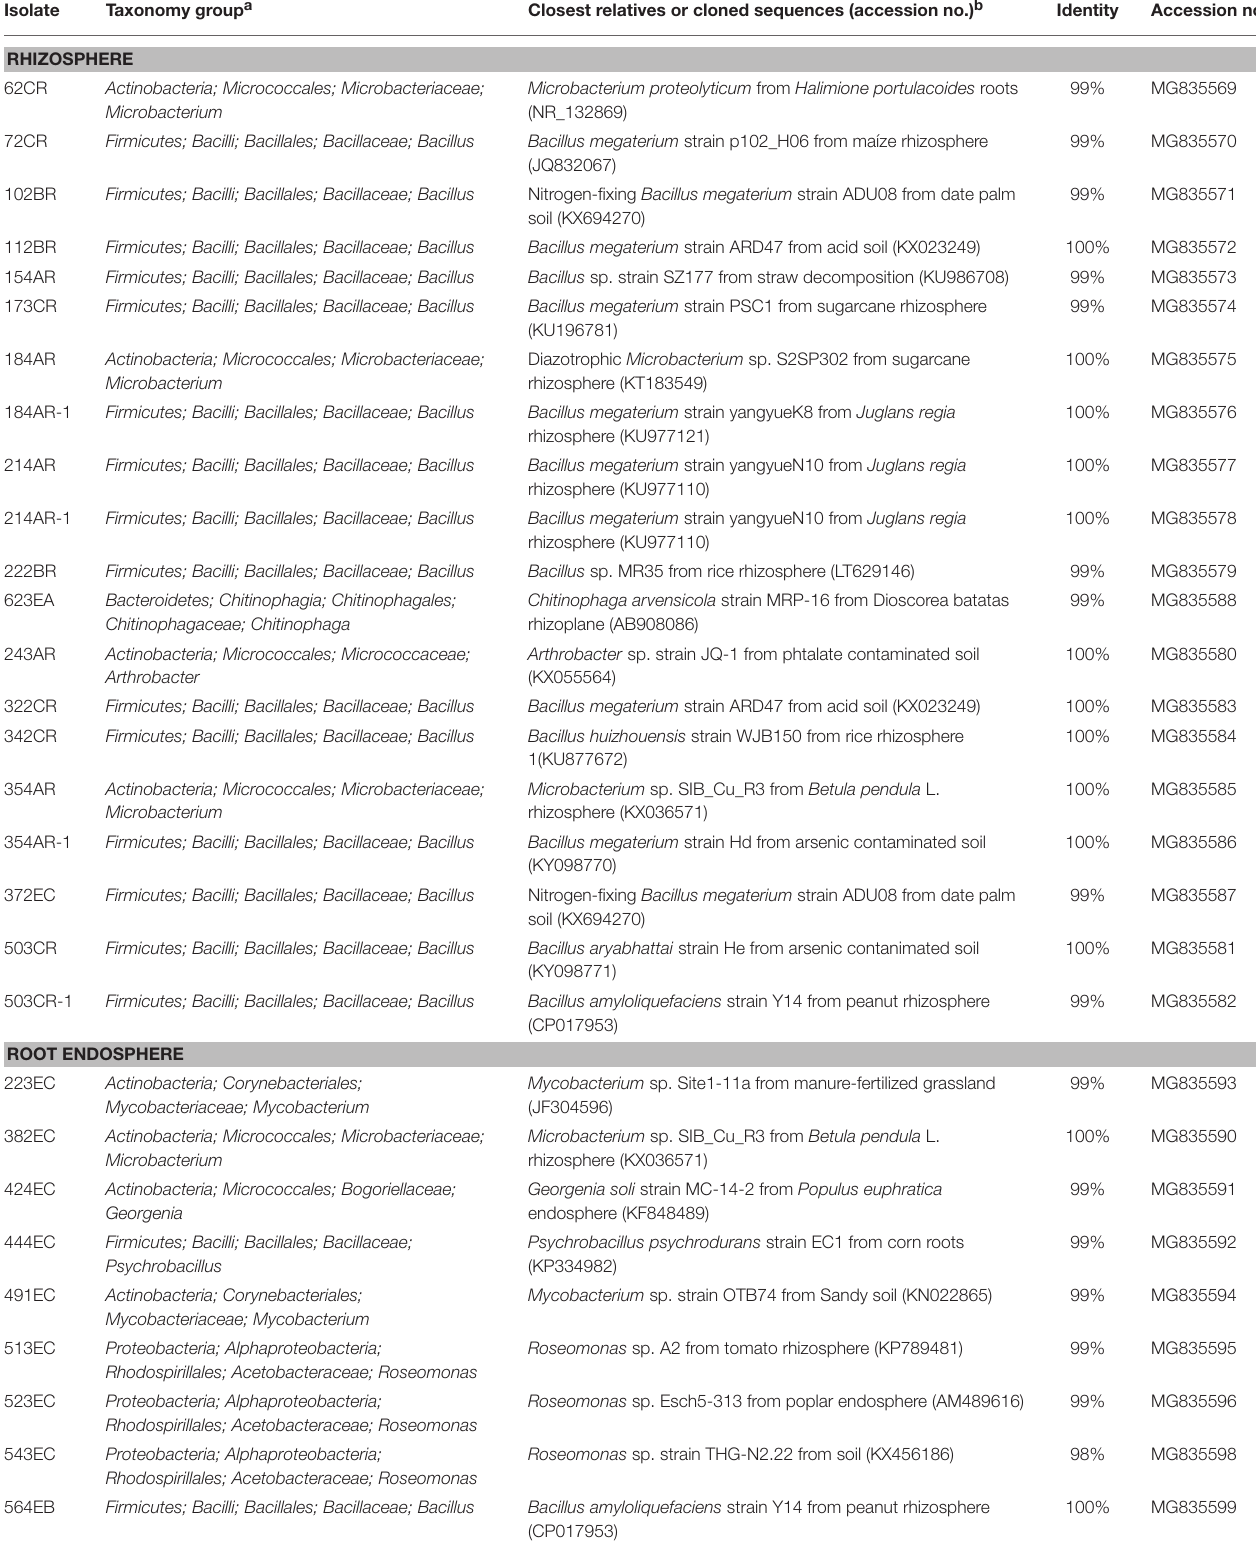
TABLE 2 | Taxonomic identity of putative N 2 -fixing bacteria isolates obtained by sequencing of 16S rRNA genes. Isolate Taxonomy group a Closest relatives or cloned sequences (accession no.) b Identity Accession